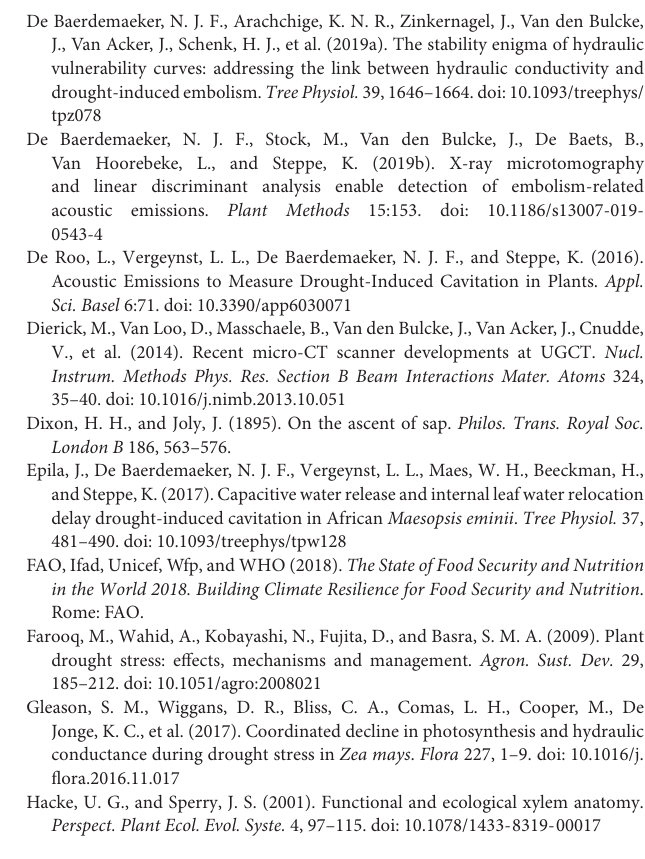
Supplementary Figure 1 | Detail of a cross-section from the stem of (A) Dublet, (B) US2014, (C) Hartog, (D) Excalibur, and (E) Duiker Max. For each cultivar, phloem (ph), metaxylem (m), protoxylem (p), parenchyma (Pa), sclerenchyma (Sc), and lacunae (L) are